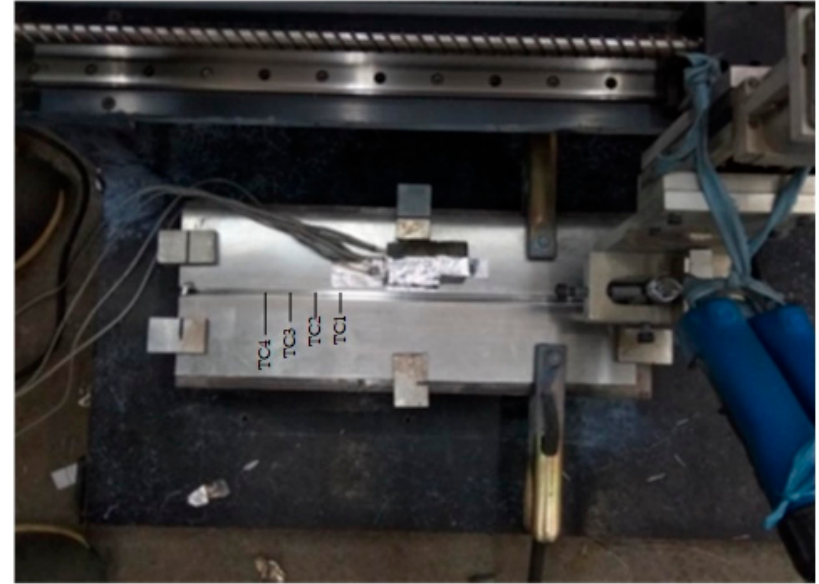
Figure 1. Semi-automatic welding tool.